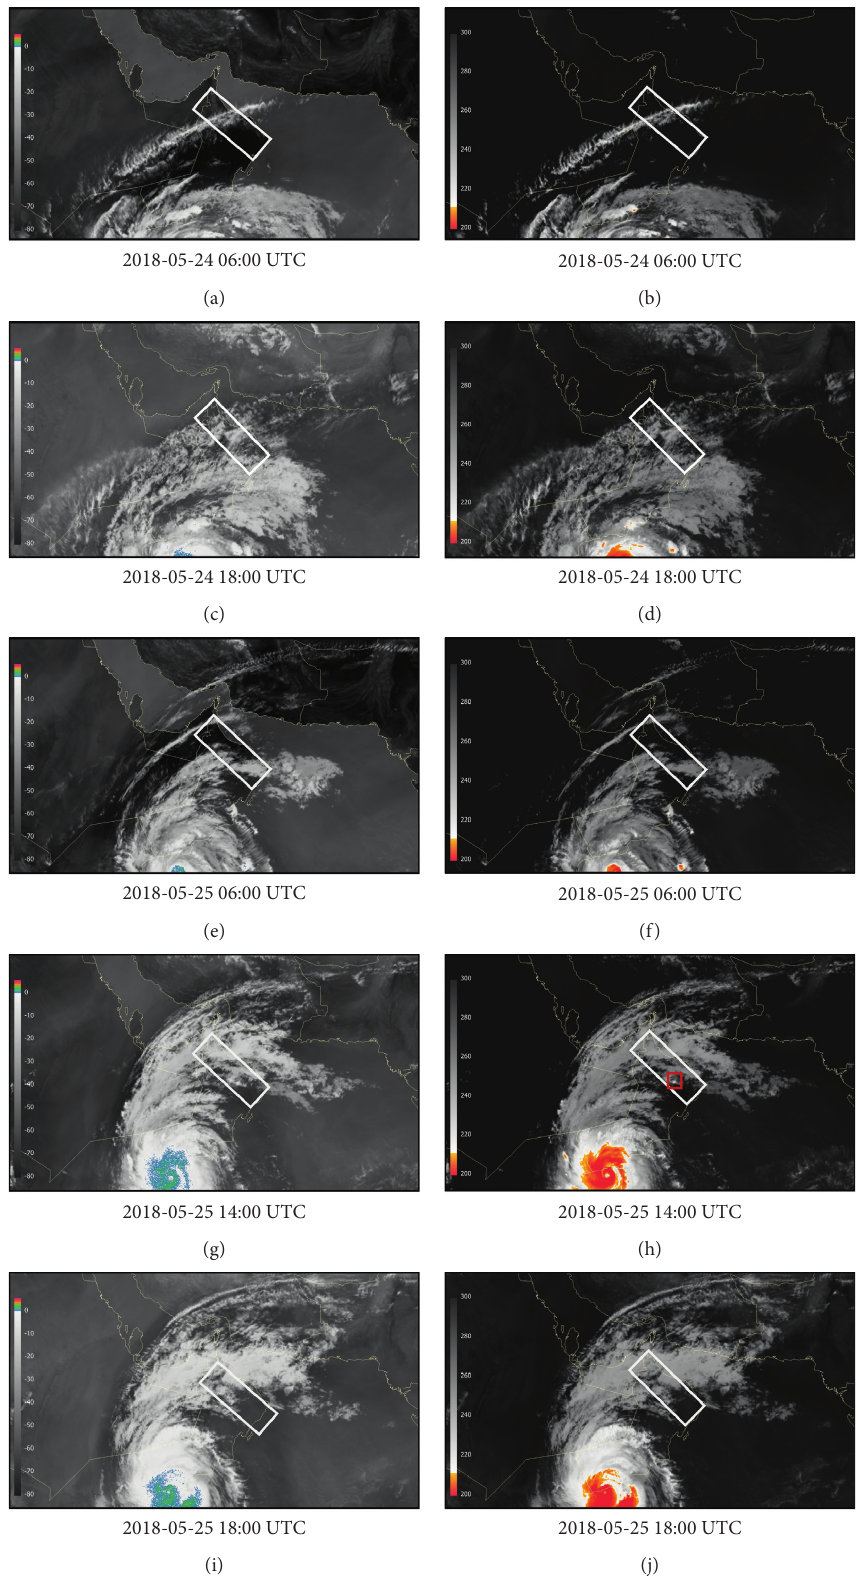
Figure 20: Sequence of BTD (WV6.2 μ m–IR10.8 μ m) images (right) and coldest brightness temperature IR10.8 μ m (left) on 24 and 25 May